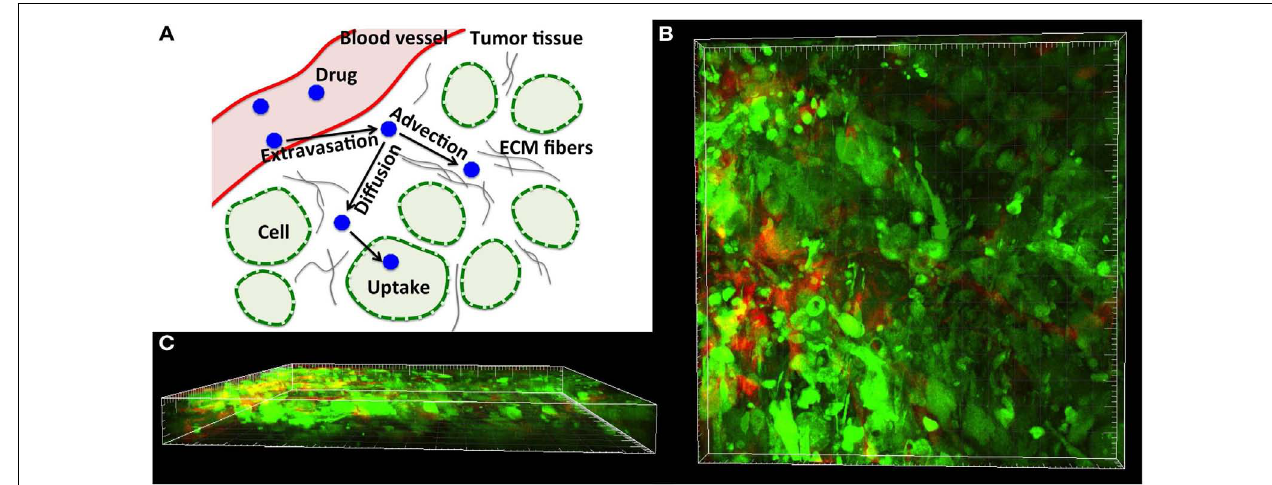
(MPE) microscopy image reconstruction (400 × magnification) of the human MDAMB231/GFP xenograft tumor from the dorsal-skin fold window chamber. (C) Horizontal view of (B) showing the depth in the tissue structure. Staining: green-tumor cells, red-vasculature.